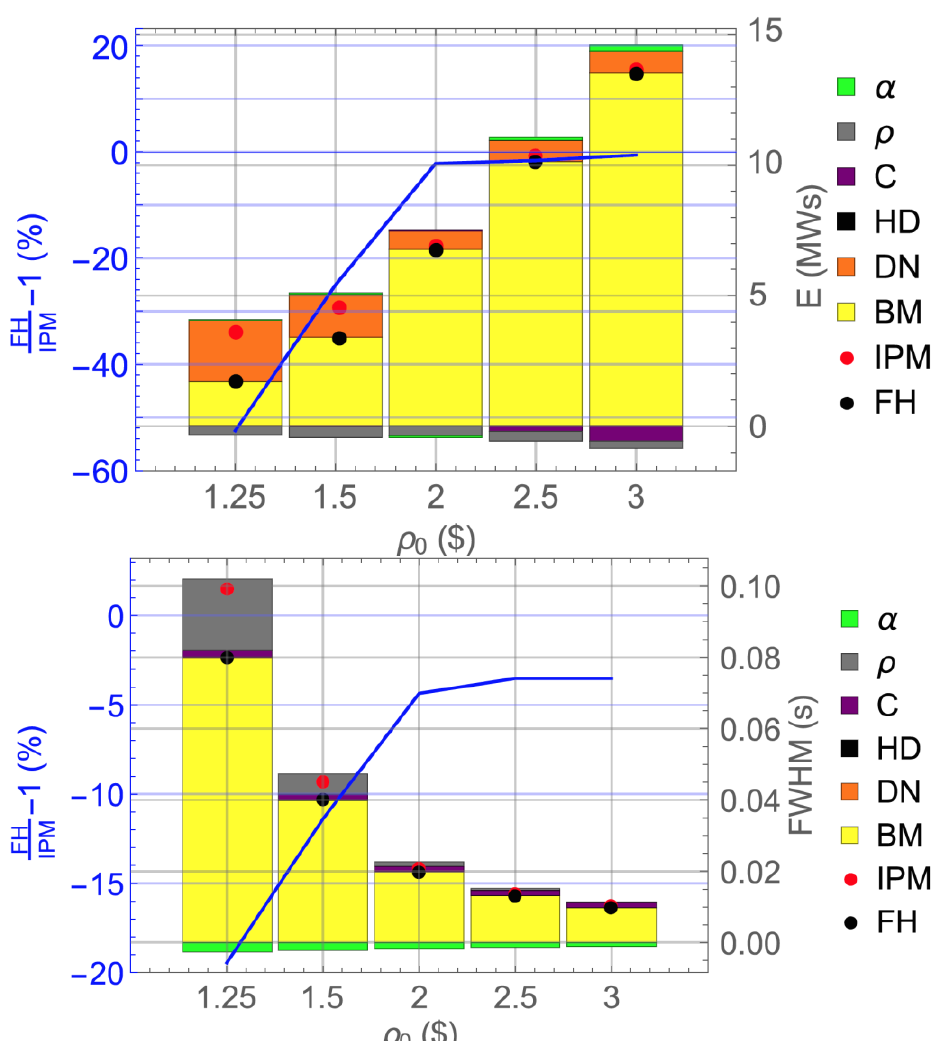
Figure 4: Comparison of the IPM and FH for P inserted reactivity. Individual contributions of improvements of IPM and relative deviations of FH